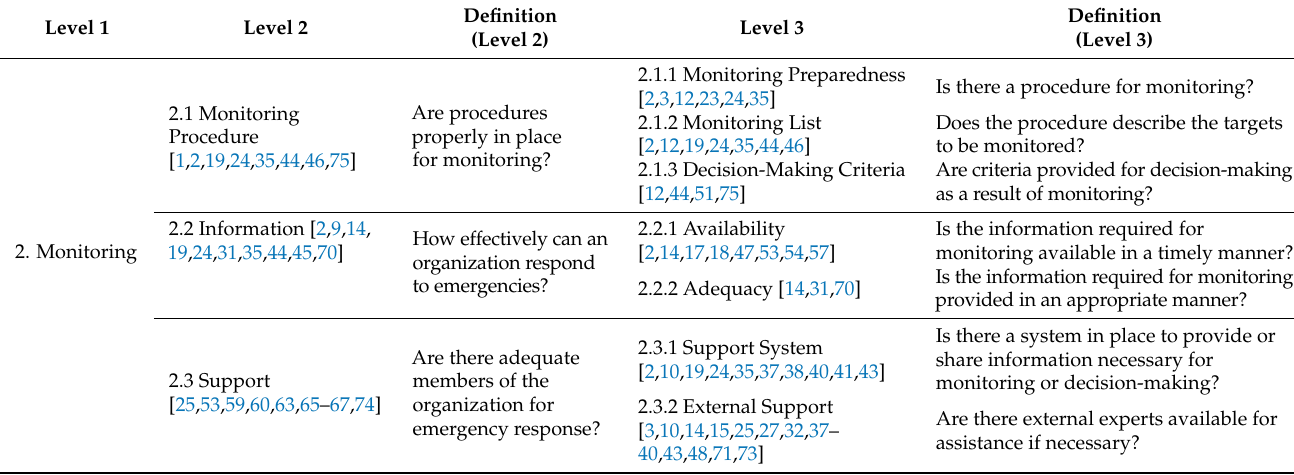
Table 9. Definitions and contributing factors for monitoring